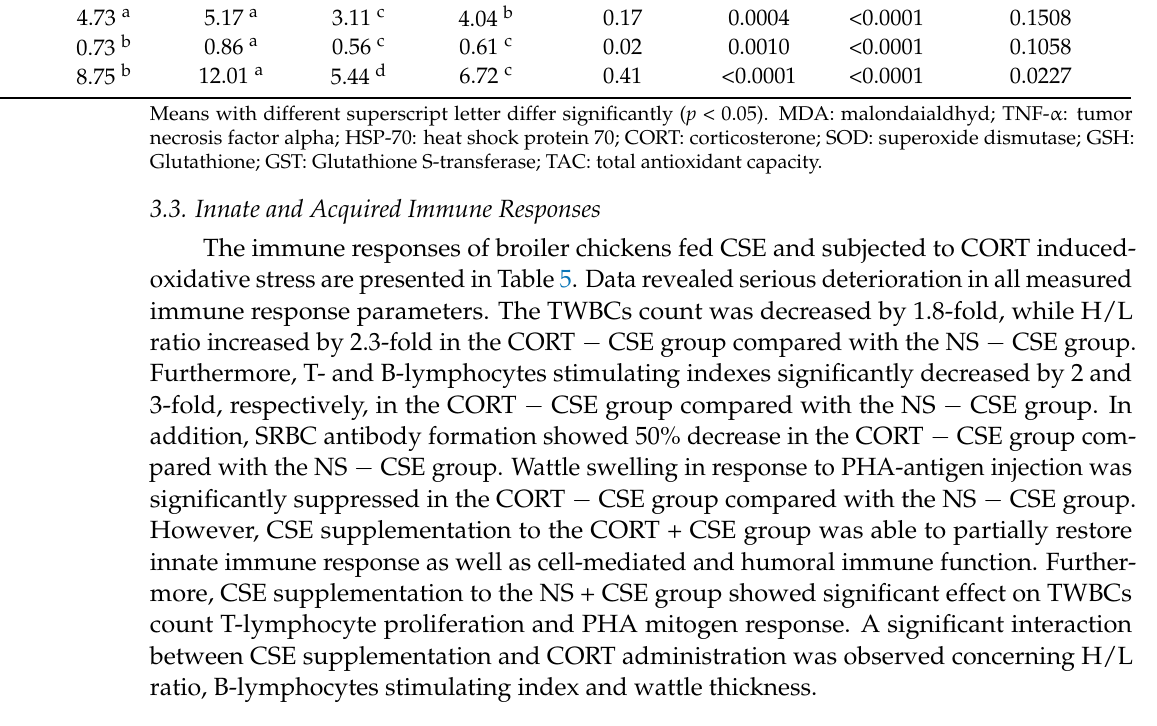
Table 5. Immune response related parameters of broiler chickens fed corn silk extract (CSE) and subjected to corticosterone-induced oxidative stress